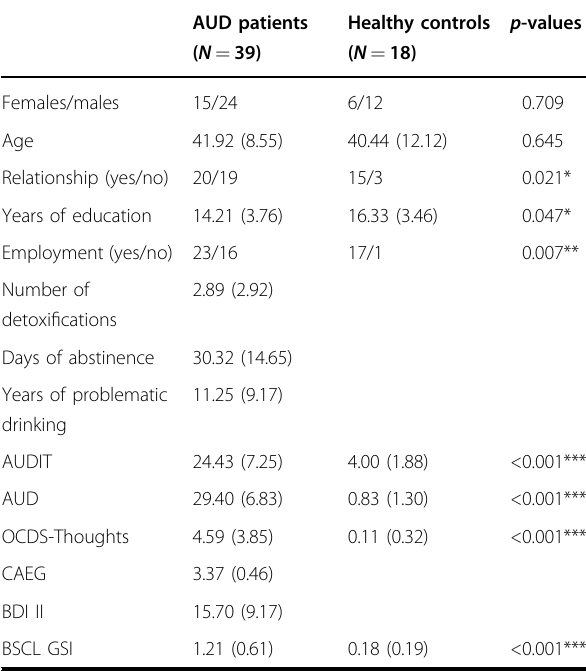
Table 1 Sociodemographic and clinical